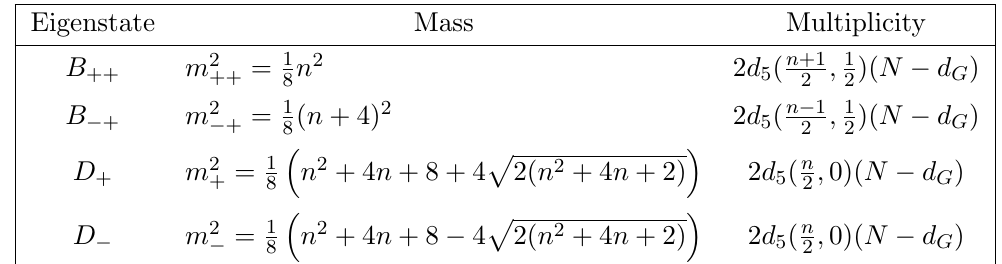
Table 3 . Masses and eigenstates of the complicated bosons in the adjoint block. The allowed ranges of L 1 and L 2 are 0 (cid:20) L 2 (cid:20) L 1 , L 1 + L 2 (cid:20) n . Note that in the case L 2 = L 1 the B 00 and D 0 (cid:12)elds are missing, and in the case L 2 = 0 the B (cid:0)(cid:0) and D 0 (cid:12)elds are missing. The de(cid:12)nition of d 5 can be found in (A.8).